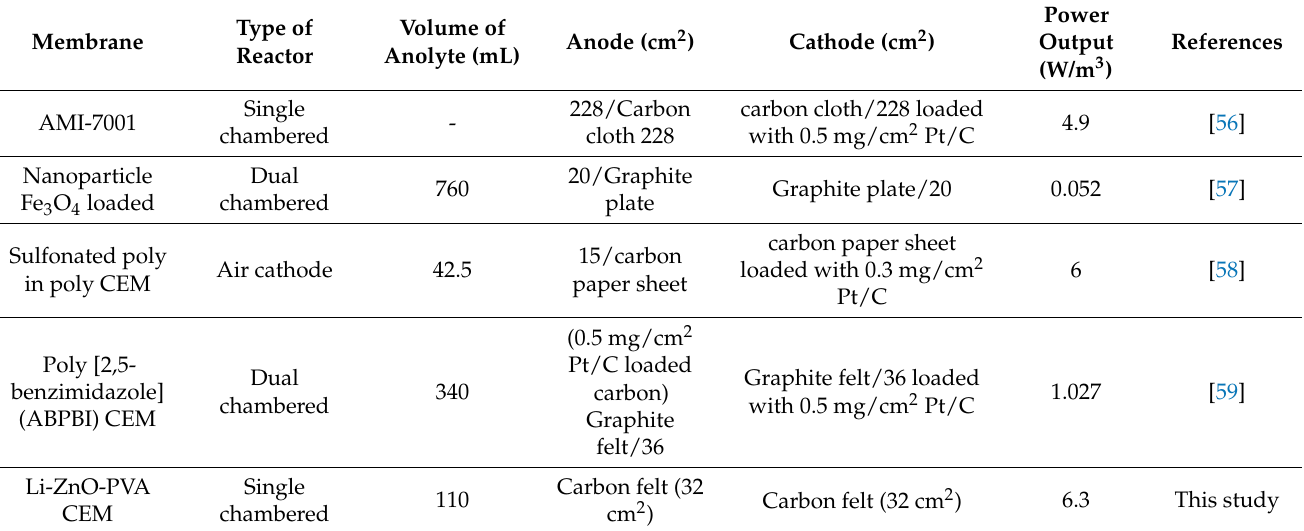
Table 3. Comparison of electrochemical performance of various types of ion exchange